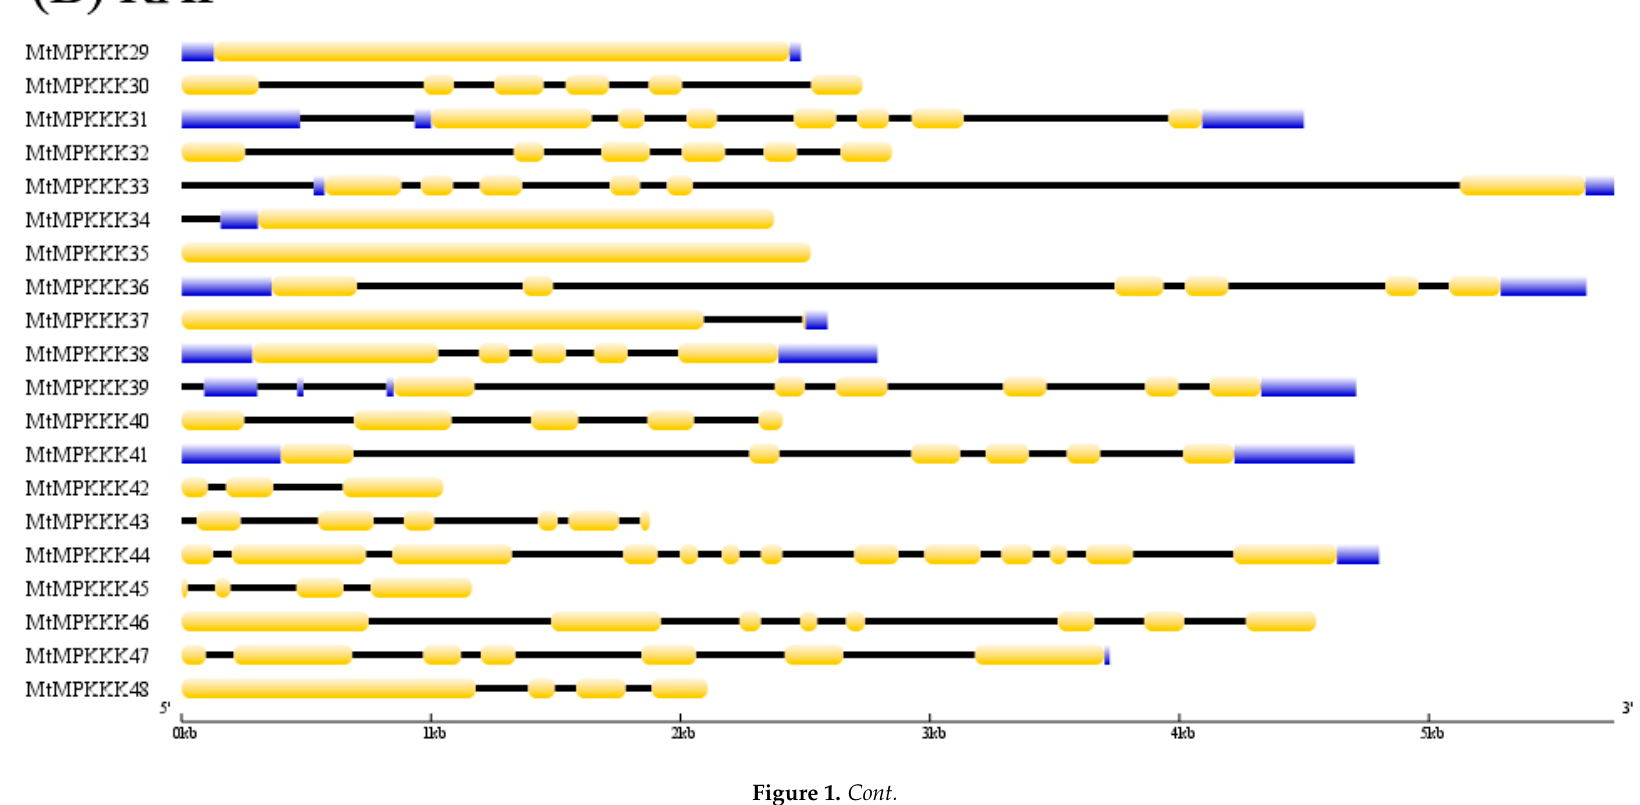
Figure 1. Cont. Figure 1.